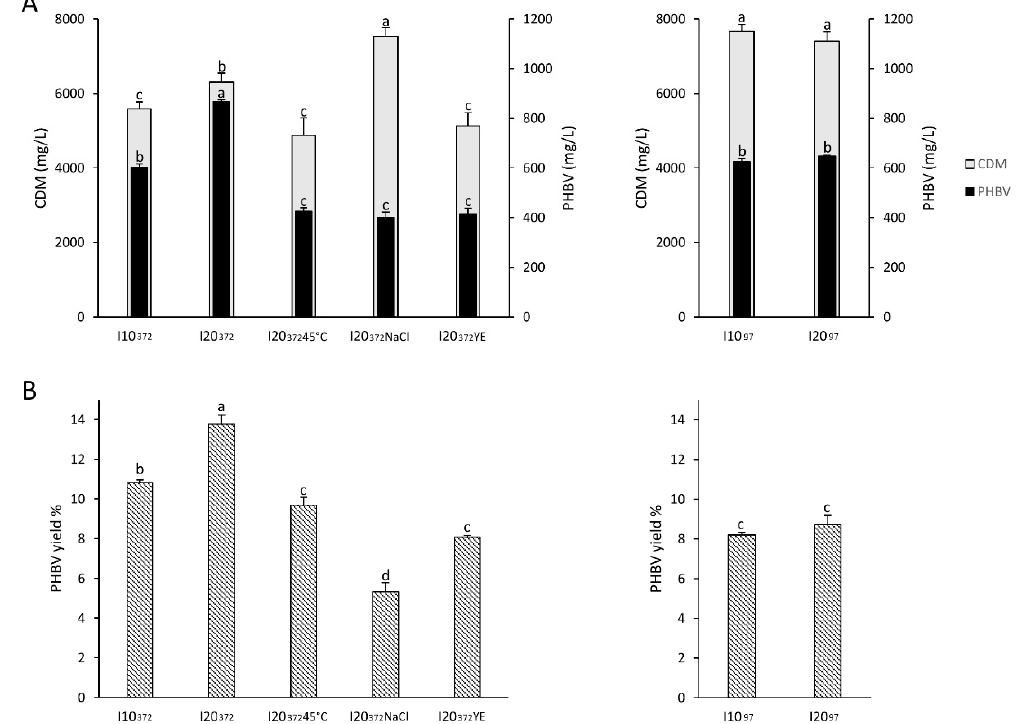
Figure 2. Haloferax mediterranei DSM1411 Cell Dry Mass (CDM) and PHBV production (panel A ) and yield (panel B ) in different fermentation conditions. R-NF was supplemented with 1% ( v / v ) SL-6 and 10% ( w / v ) NaCl. Inoculum was made with 10 (I10) or 20% v / v (I20) active cultures of Haloferax mediterranei DSM1411 grown (24 h at 37 °C) in HM372 (I10-I20 372 ) or HM97 (I10-I20 97 ) media. Fermentation was carried out at 37 °C for all the thesis, with the exception of I20 372 45, incubated at 45 °C. 10% w / v NaCl (final concentration 20%) or 5 g/L YE were added to the substrate inoculated with 20% of active culture in HM372 (I20 372 NaCl and I20 372 YE). In all cases, fermentation lasted 120 h. Error bars represent the standard deviation of three replicates. a–d Values in the same panel and data series, with different superscript letters, differ significantly ( p < 0.05).